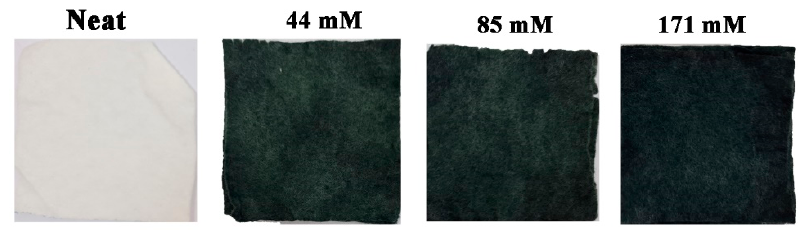
Figure 1. Neat and PANI-coated 50:50 PET:viscose fabrics at different PANI concentrations.